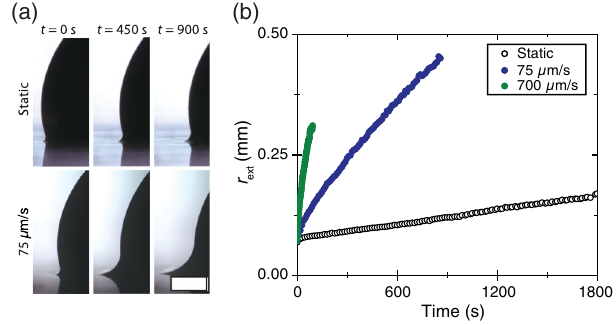
FIG. 2. (a) Time-lapse images of the wetting ridge for static and moving droplets (scale bar ¼ 0 . 5 mm). (b) Growth of r over time for static and moving droplets. As can be seen in both (a) and (b), the wetting ridge grows more quickly for the moving droplets. In all cases, 25 - μ l droplets are placed on a surface infused with 20-cP silicone oil with an initial film thickness of 4 μ m.